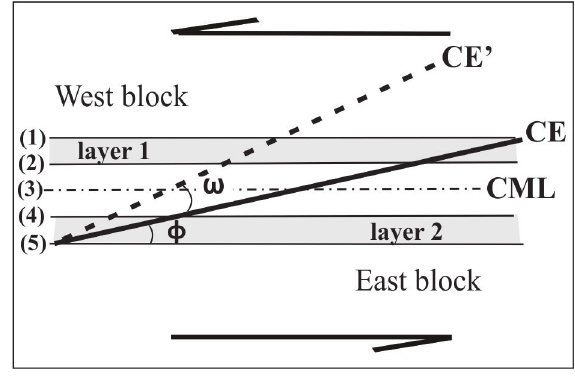
Figure 3 - Schematic representation of the marker horizons. The marker lines are labelled with numbers to facilitate the description in the text. CE = cross-cutting element; CE’ = cross-cutting element after rotation; CML = central marker line; ϕ = angle between the CE and the marker lines that are parallel to the shear zone boundary; ω = CE rotation angle during progressive deformation; blocks are named east and west blocks relative to the